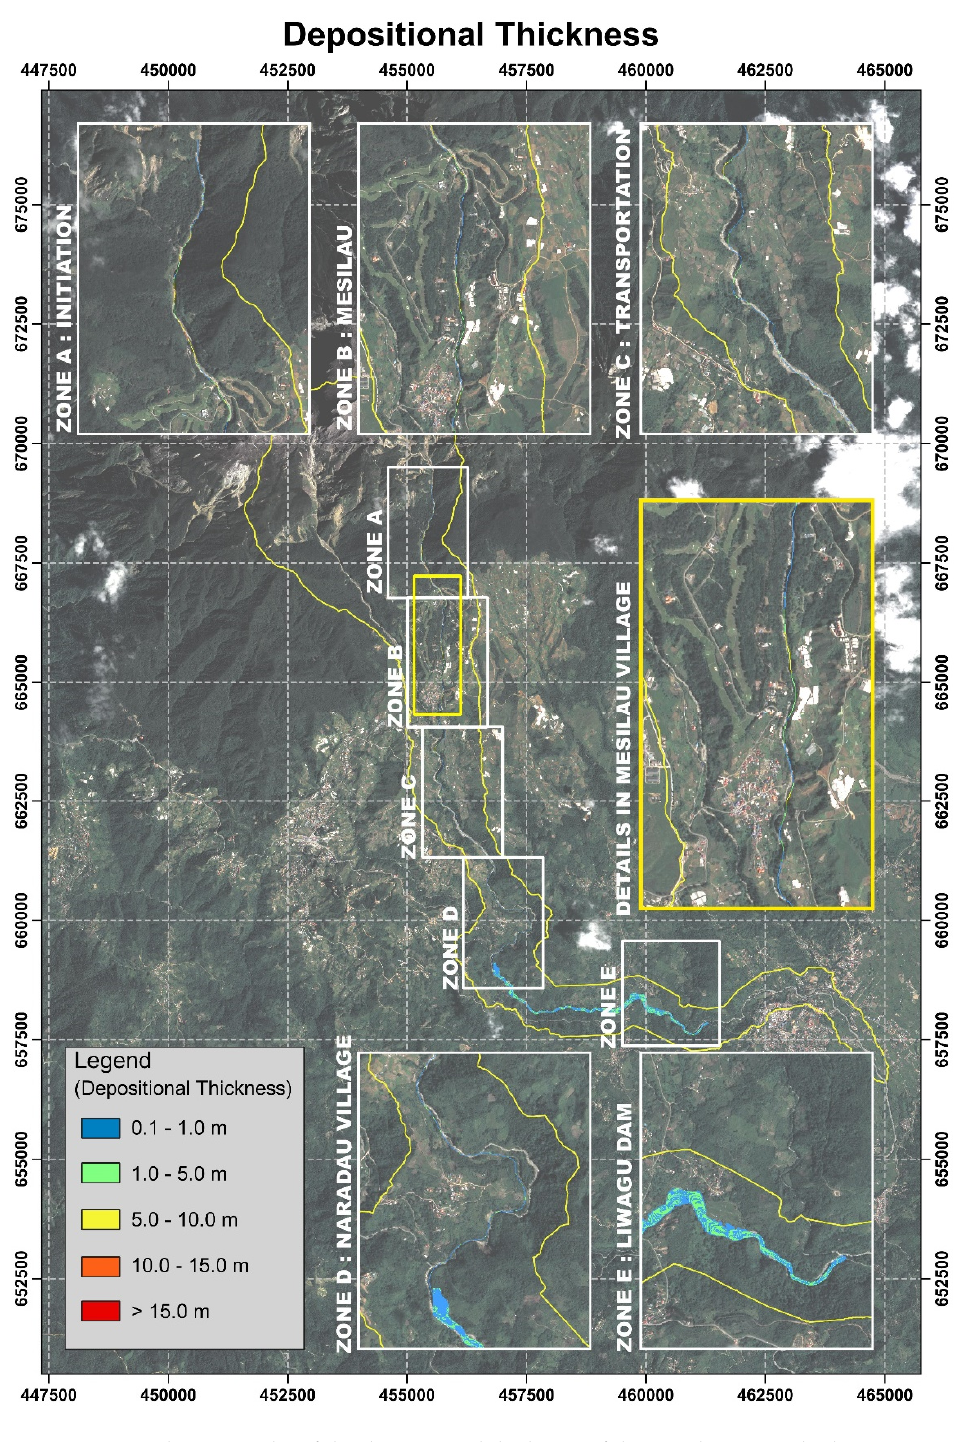
Figure 14. Simulation results of the depositional thickness of the Mesilau watershed.